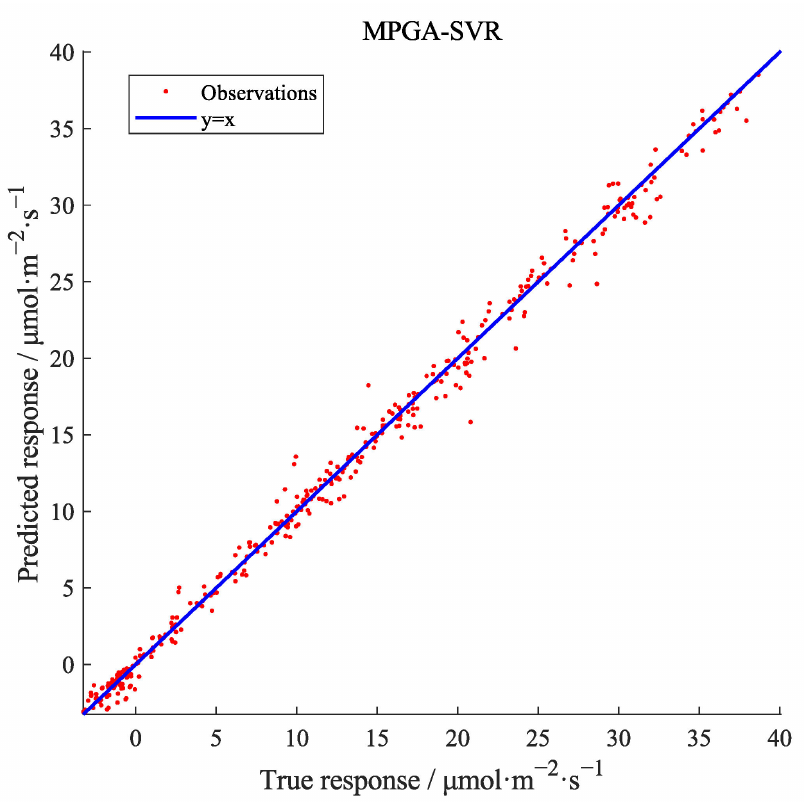
Figure 6. The true response vs. the predicted response of the MPGA-SVR model on the test